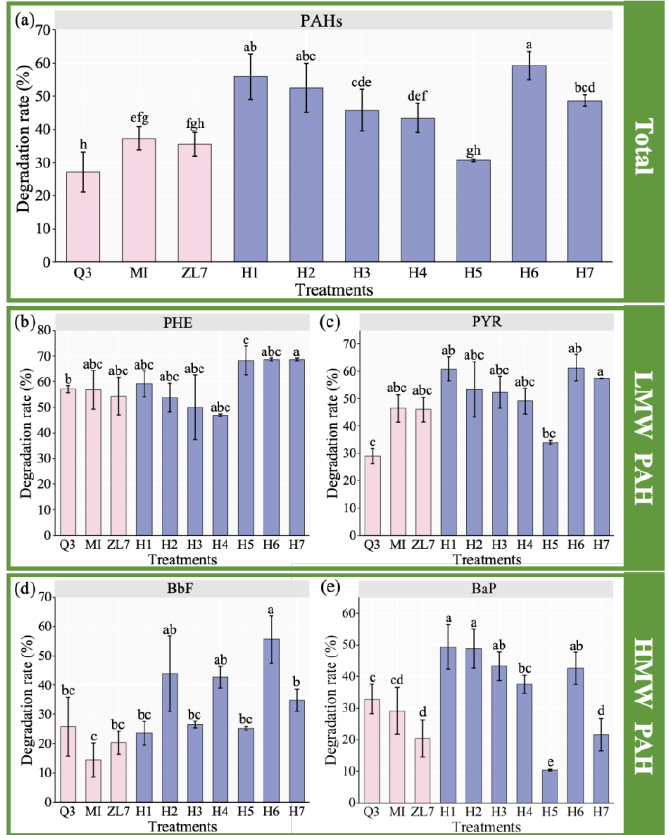
Figure 3. Degradation rate of the PAH mixture by single strains (ZL7, MI and Q3) and the microbial consortia in liquid medium. ( a ) Degradation rate of the total PAH mixture; ( b ) Degradation rate of phenanthrene(PHE) in PAHs mixture; ( c ) Degradation rate of pyrene(PYR) in PAHs mixture; ( d ) Degradation rate of benzo[b]fluoranthene(BbF) in PAHs mixture; ( e ) Degradation rate of benzo[a]pyrene(BaP) in PAHs mixture; Error bars represent the standard deviation ( n = 3). Different letters indicate the mean difference is significant between treatments at 0.05 level. H1 (ZL7:MI = 1:1), H2 (Q3:ZL7 =